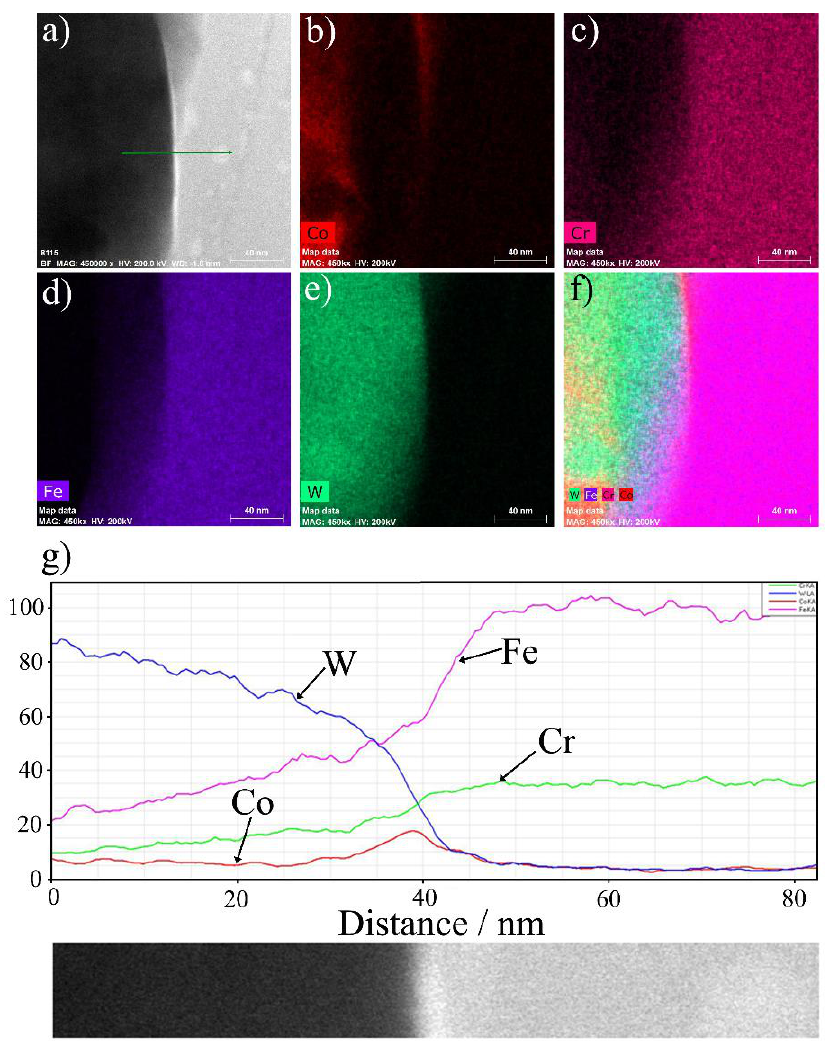
Figure 6. TEM image of the microstructure, EDS mapping and line scanning of the interface between WC–CoCr cermet and Fe-based amorphous alloy: ( a ) microstructure; ( b – f ) elements mapping; and ( g ) W, Fe, Co, Cr-element line scanning result of the arrow line in ( a ) and the corresponding enlarged microstructure image. The direction of the arrow means the scanning direction.